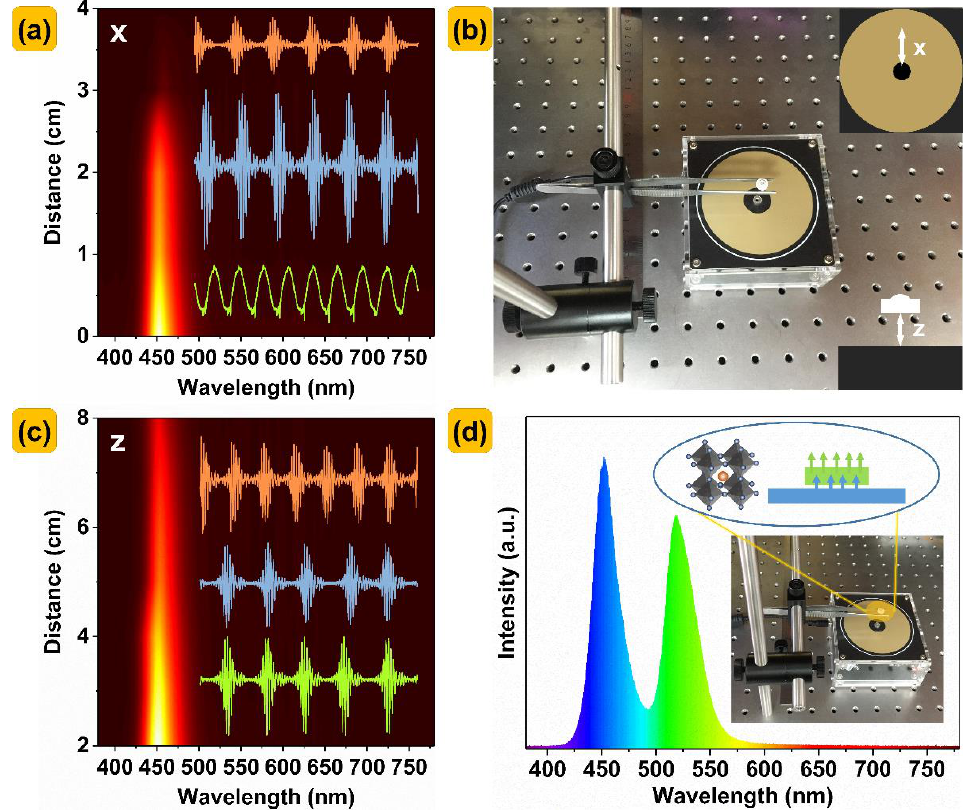
Figure 8. The relationship between the distance and spectra of the LEDs and Tesla coils in ( a ) x− and ( c ) z−directions. ( b ) Schematic diagram of contactless electroluminescence devices. ( d ) EL spectra of the LEDs encapsulated with Cs(Pb,Mn)Br 3 PQDs@glasses by contactless electroluminescence devices.